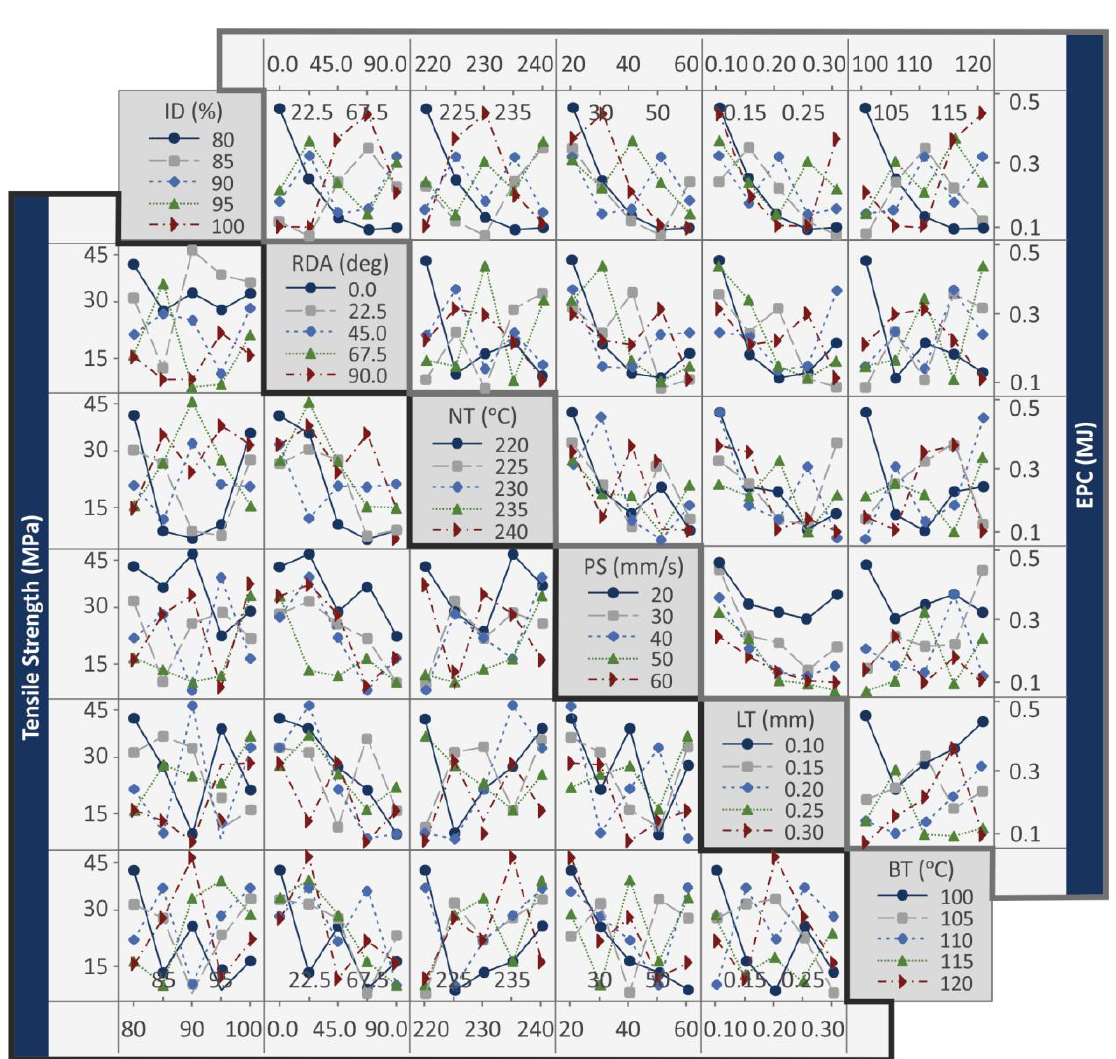
Figure 10. Interaction plots: tensile strength (MPa), EPC (MJ).